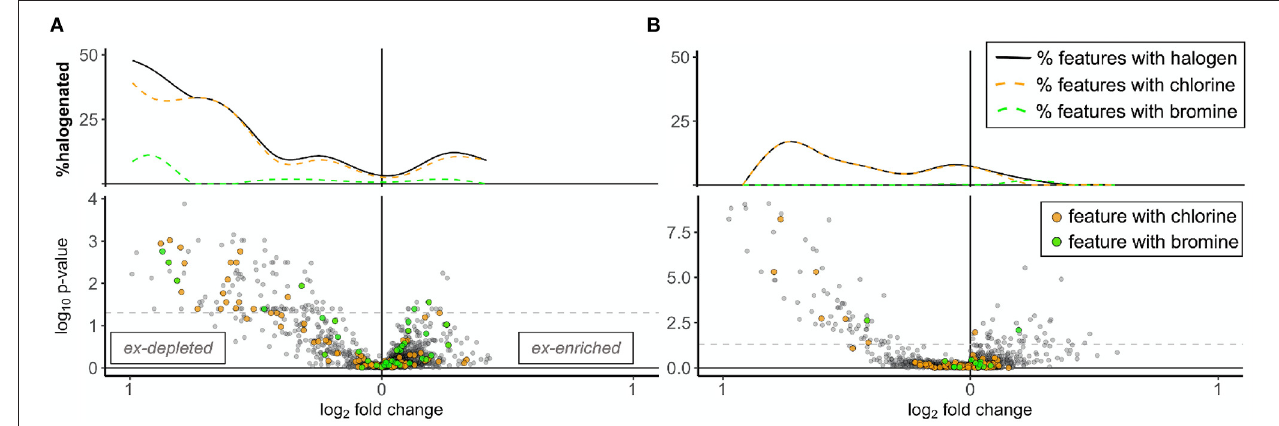
FIGURE 5 | Histograms and volcano plots showing the dispersion of halogenated features in combined A. tubulata and X. muta samples for each year. Panels show samples from (A) 2018 and (B) 2019. Excurrent-depleted features are shown on the left (x <0) and excurrent-enriched features on the right (x >0) of each plot. Dashed gray lines on the volcano plot signify p = 0.05, above which all features were significantly more abundant in incurrent or excurrent samples. Colors denote halogenation, with orange representing chlorines and green representing bromines. Histograms above volcano plots show the percentage of total features determined to be chlorinated (orange dashed line), brominated (green dashed line) and total (solid black